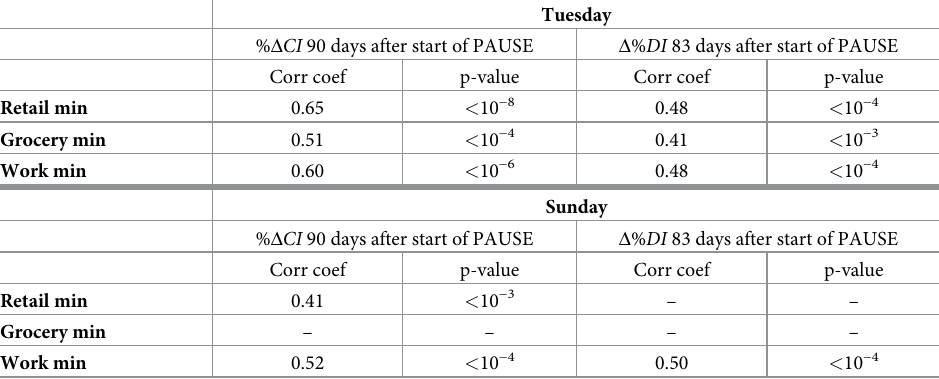
Table 4. Spearman correlations between lowest weekly mobility levels in New York counties shorty following PAUSE, and epidemic control by June 20, 2020. As measures of epidemic control, we used % Δ CI and Δ % DI , between the start of PAUSE and the end of our study. The lowest mobility levels to Retail, Grocery and Workspace were com- puted separately for each day of the week; the table shows the results for correlations with Tuesday and Sunday time